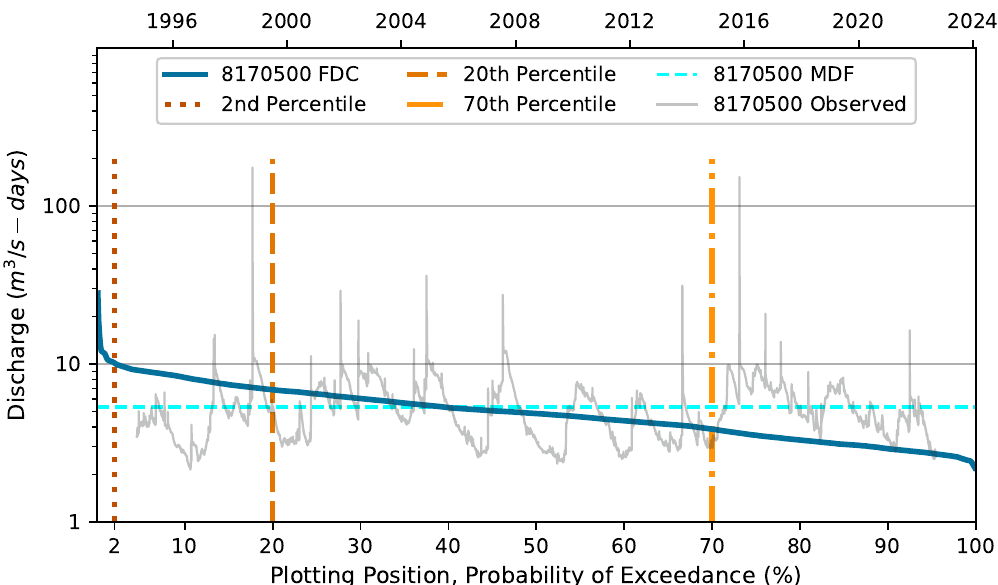
Plotting Position, Probability of Exceedance (%) Figure 5. Daily flow duration curve (FDC) for station 8170500 on the San Marcos River. Note that all observed discharge values are greater than 2 m 3 /s-days denoting consistent and significant base flow from San Marcos Springs, which are located just upstream of this gauging